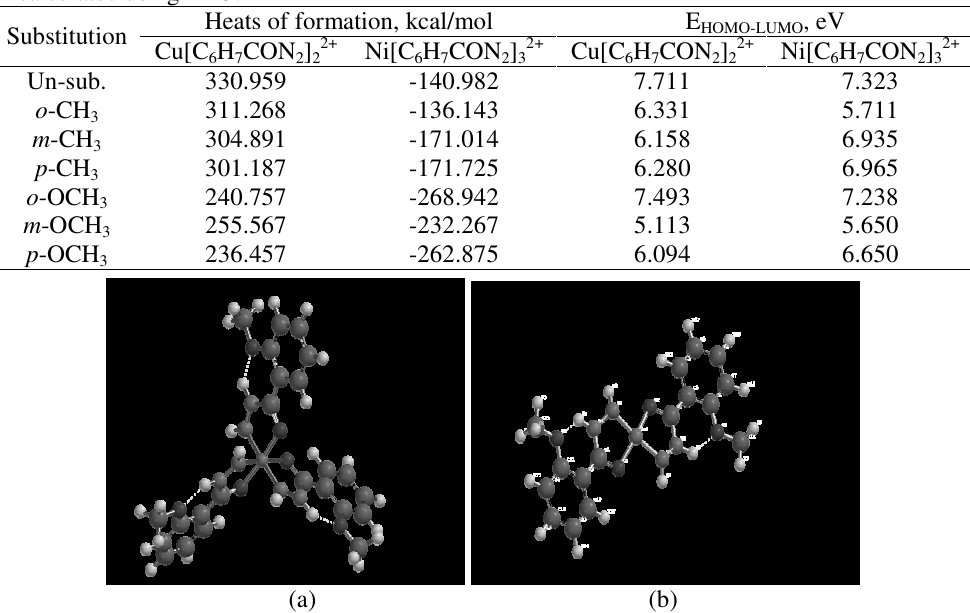
Table 1. Heats of formation (kcal/mol) and HOMO-LUMO energy difference (eV) as calculated using PM3.